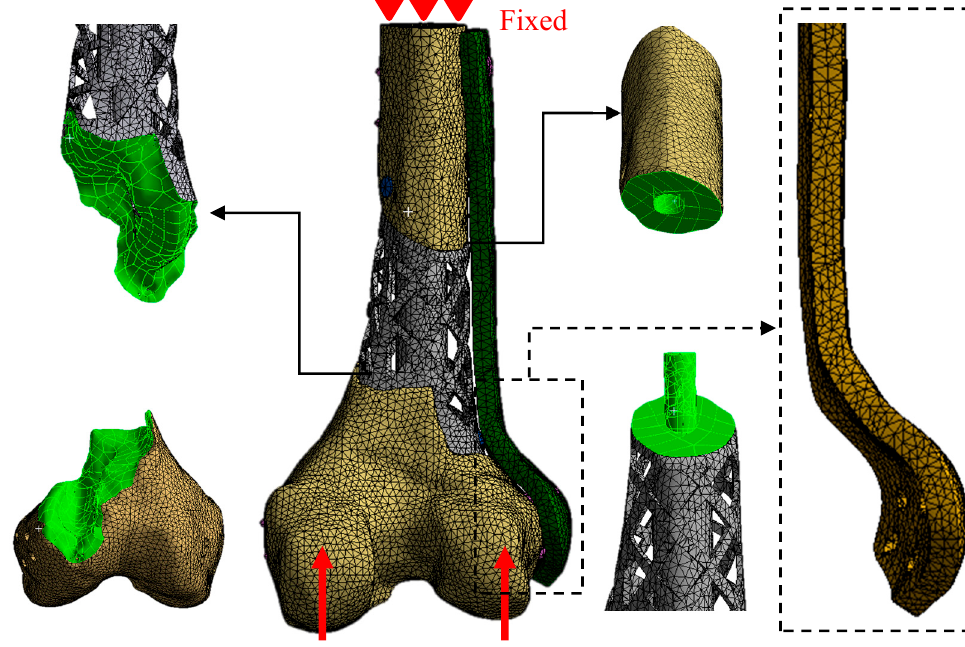
Figure 3. FE model consisted of the implant, screws, pre-contoured locking plate, and remaining right femur. Light green area showed the proximal and distal bone-implant contact interface. The force was applied separately on the medial condyle (60%) and the lateral condyle (40%), with correspond to 3 times of body weight.